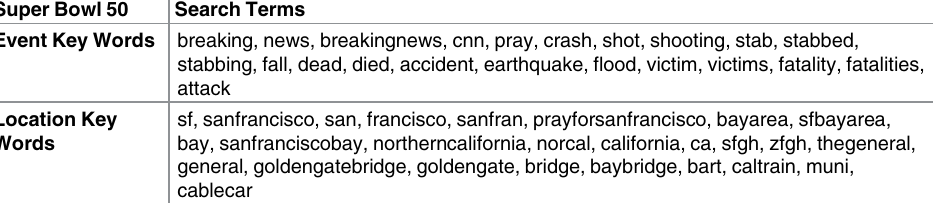
Table 2. Event & location key words utilized in the prospective test signal for Super Bowl